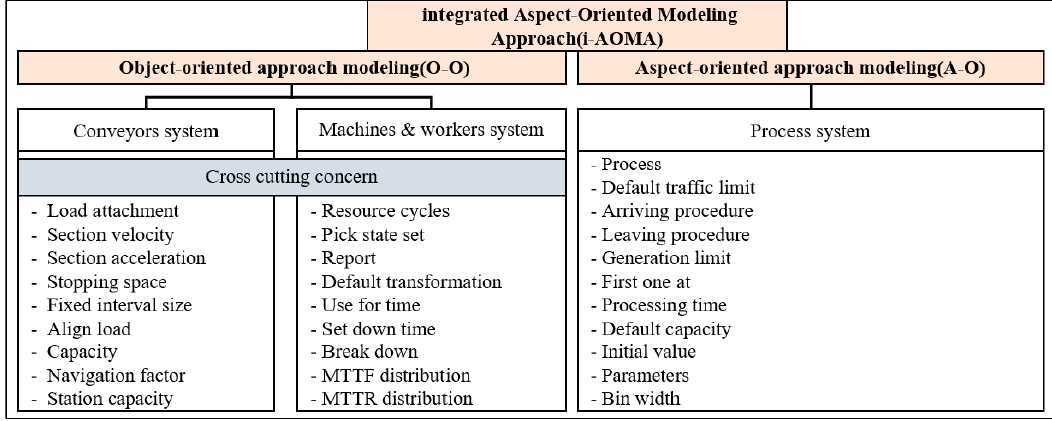
Figure 1. Concept of integrated aspect-oriented modeling approach (i-AOMA).